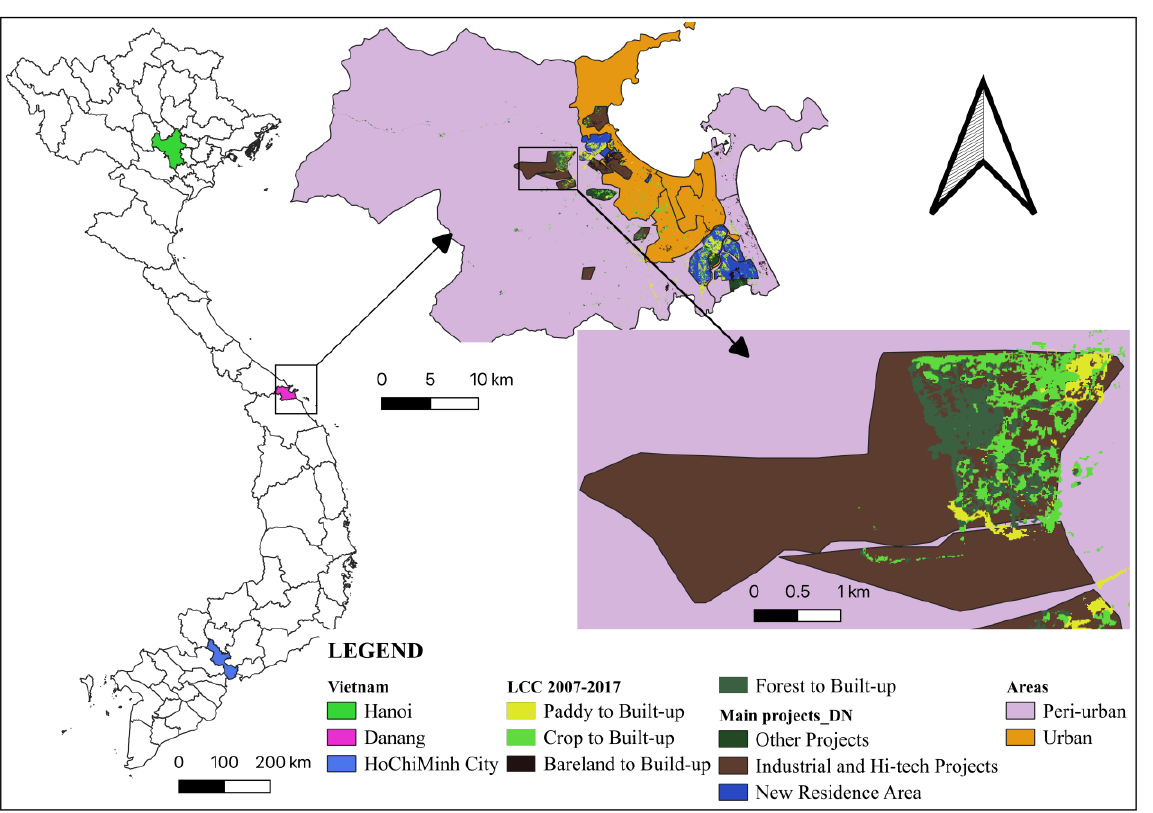
Fig. 2. The location of Da Nang and the research